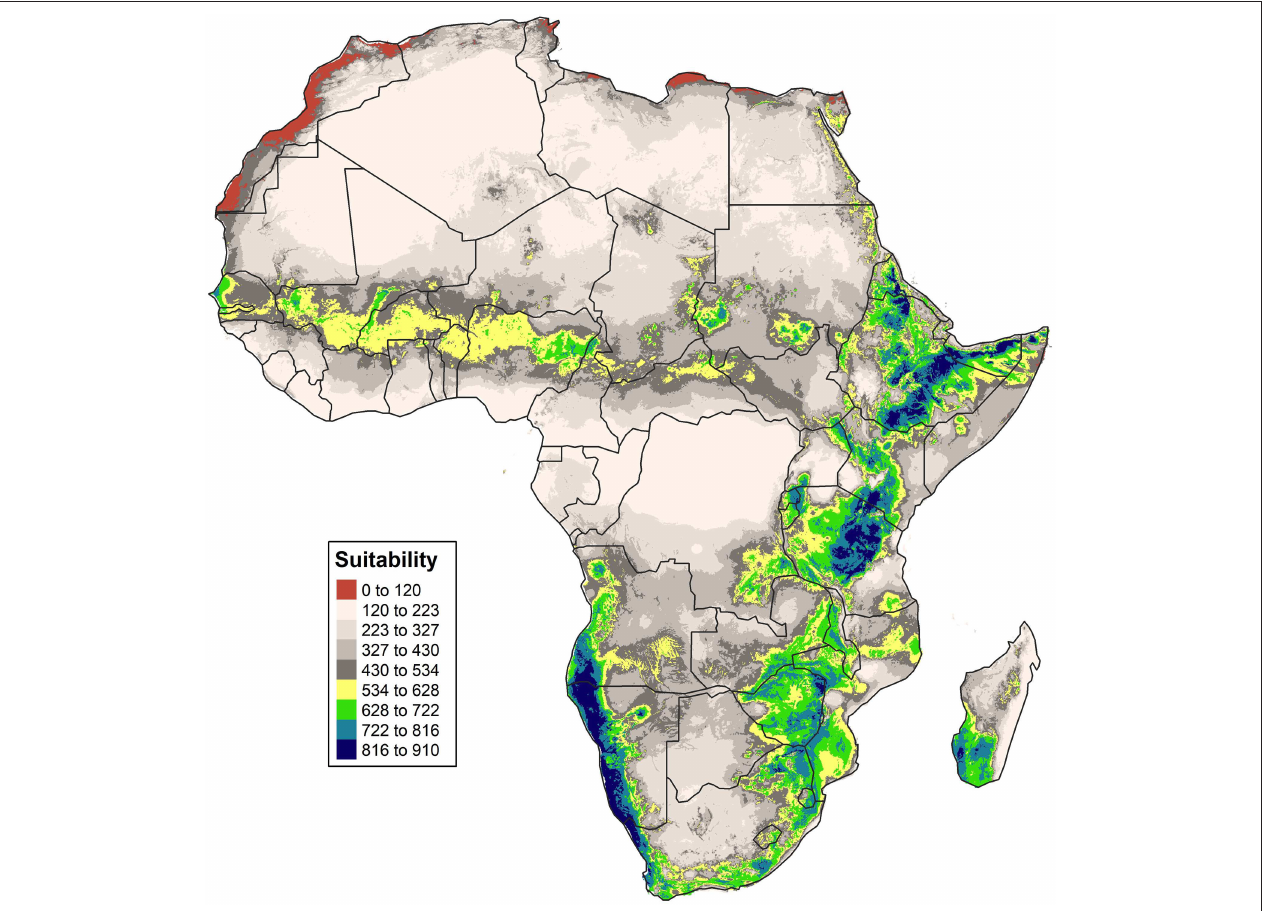
FIGURE 3 | Estimated distribution of Faidherbia albida in Africa, obtained by ensemble suitability modeling with BiodiversityR (Kindt, 2018). In the map, the green-blue colors show where the species is expected to be suitable, the gray areas where the species is not suitable and the orange areas where the species was predicted to be suitable but where those latter areas were outside a buffer around the known presence observations. Suitability values above 534 correspond to likely presence of the species with increasing values associated with higher likelihood of species presence. The suitability index is unitless can be understood as the probability of the species occurring at a given location ( de Sousa et al., 2019). Country boundaries were obtained from the tmap package [ data(World) , (Tennekes, 2018; de Sousa et al.,